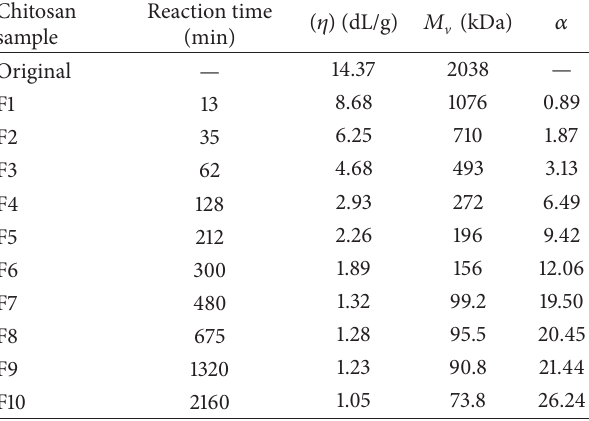
Table 1: Intrinsic viscosity, ( 𝜂 ), of chitosans in 0.25M HAc/0.25 M NaAc, viscosity-average molecular weight, 𝑀 V , and average number of chain scissions, 𝛼 , for the fragments prepared by hydrolysis fragmentation of 1.0% chitosan at different reaction times with